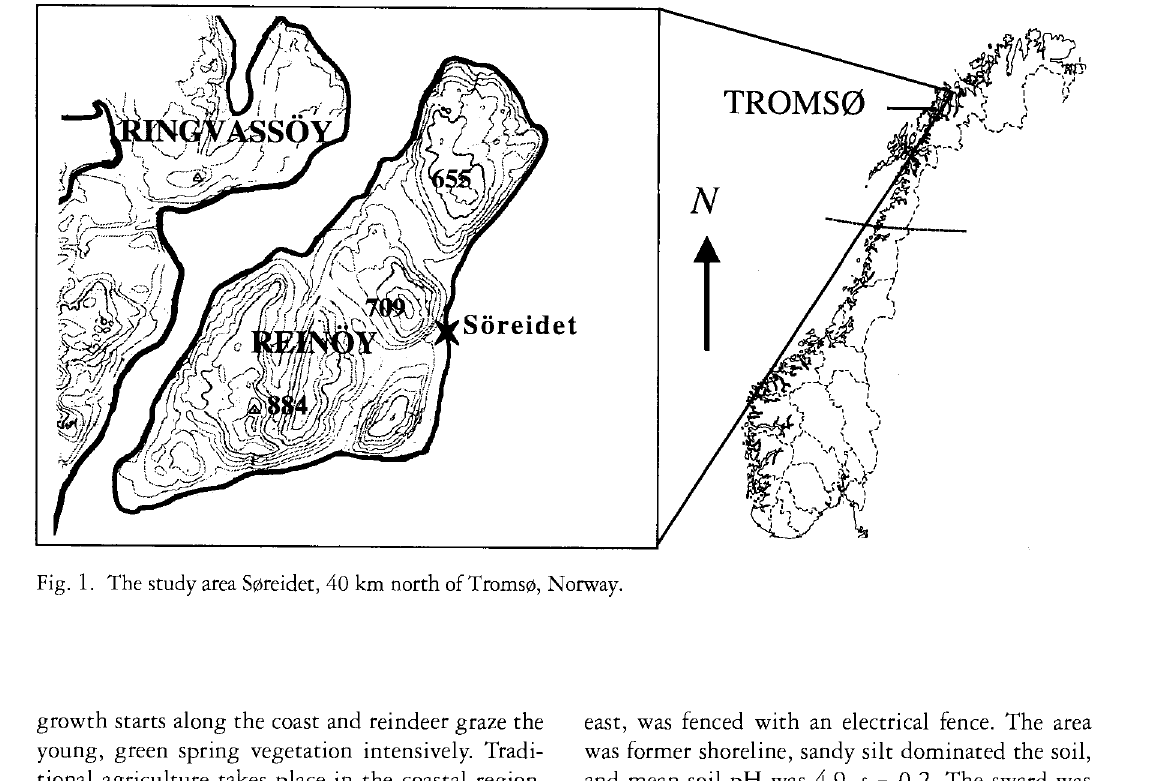
Fig. 1. The study area Søreidet, 40 km north of Tromsø,